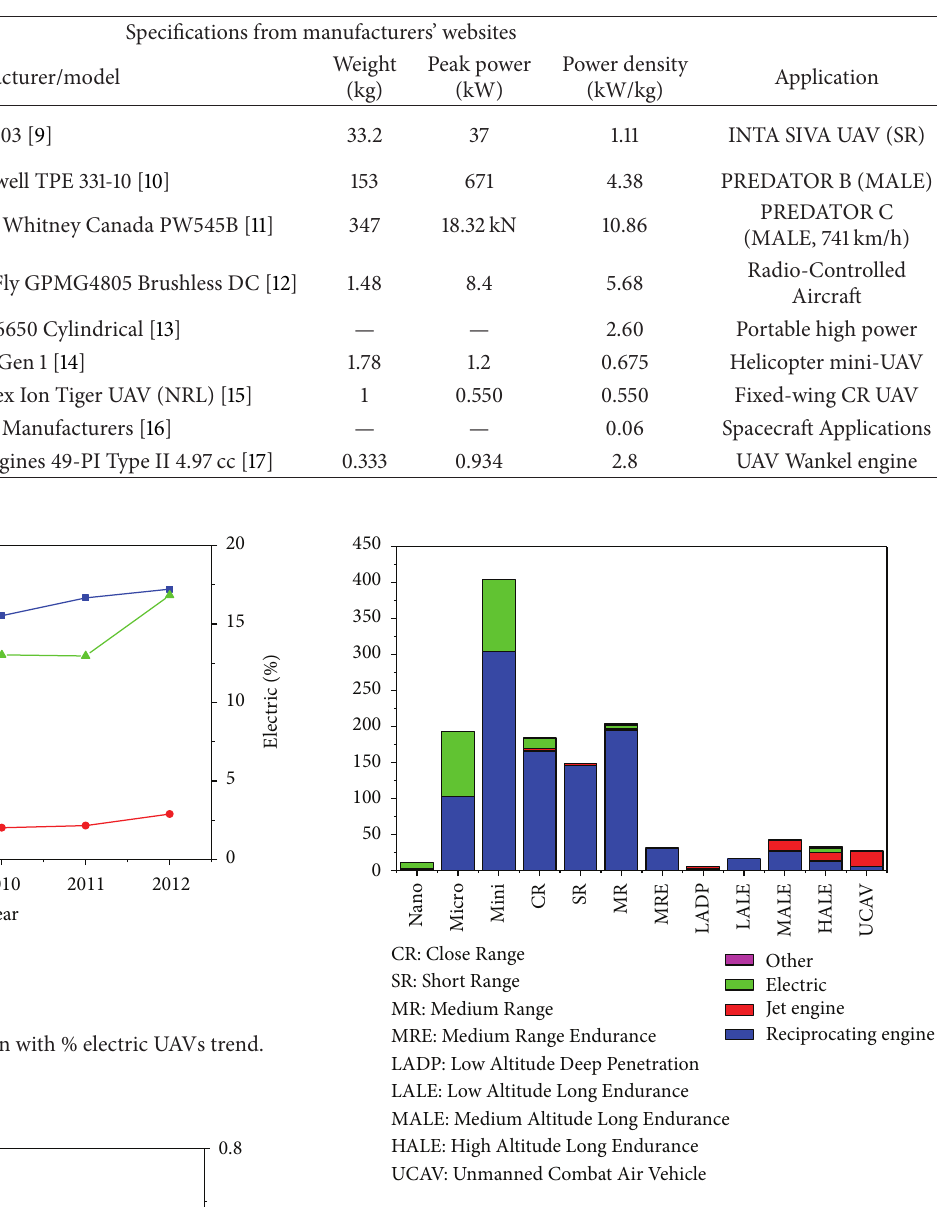
Table 1: Examples of power densities of different UAV powerplant components.